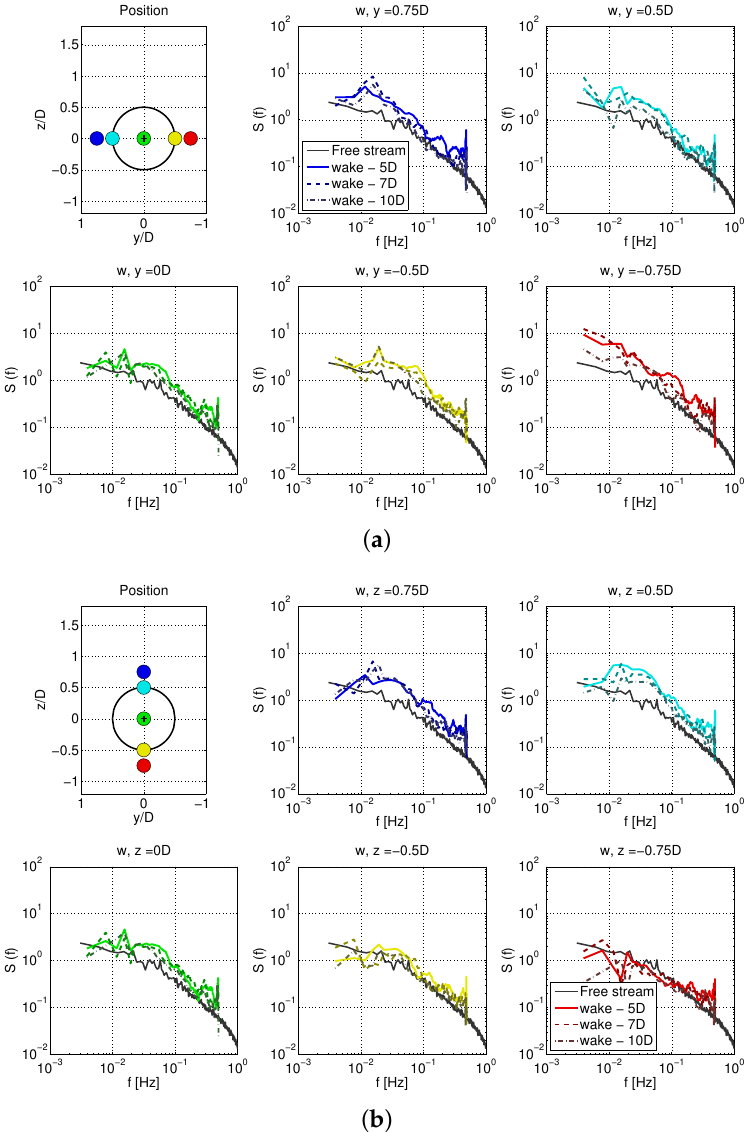
Figure 13. Power spectral density functions of w at x = 0, 5 D , 7 D , and 10 D : ( a ) lateral variation; and ( b ) vertical